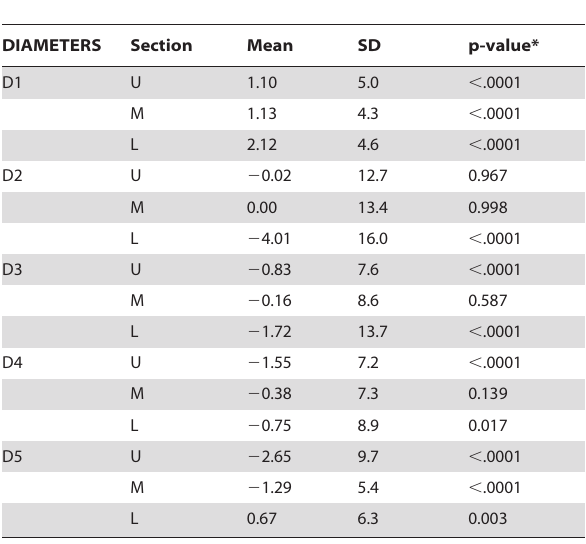
Table 2. Differences between left and right side of each measures in all subjects, with the p-value of the